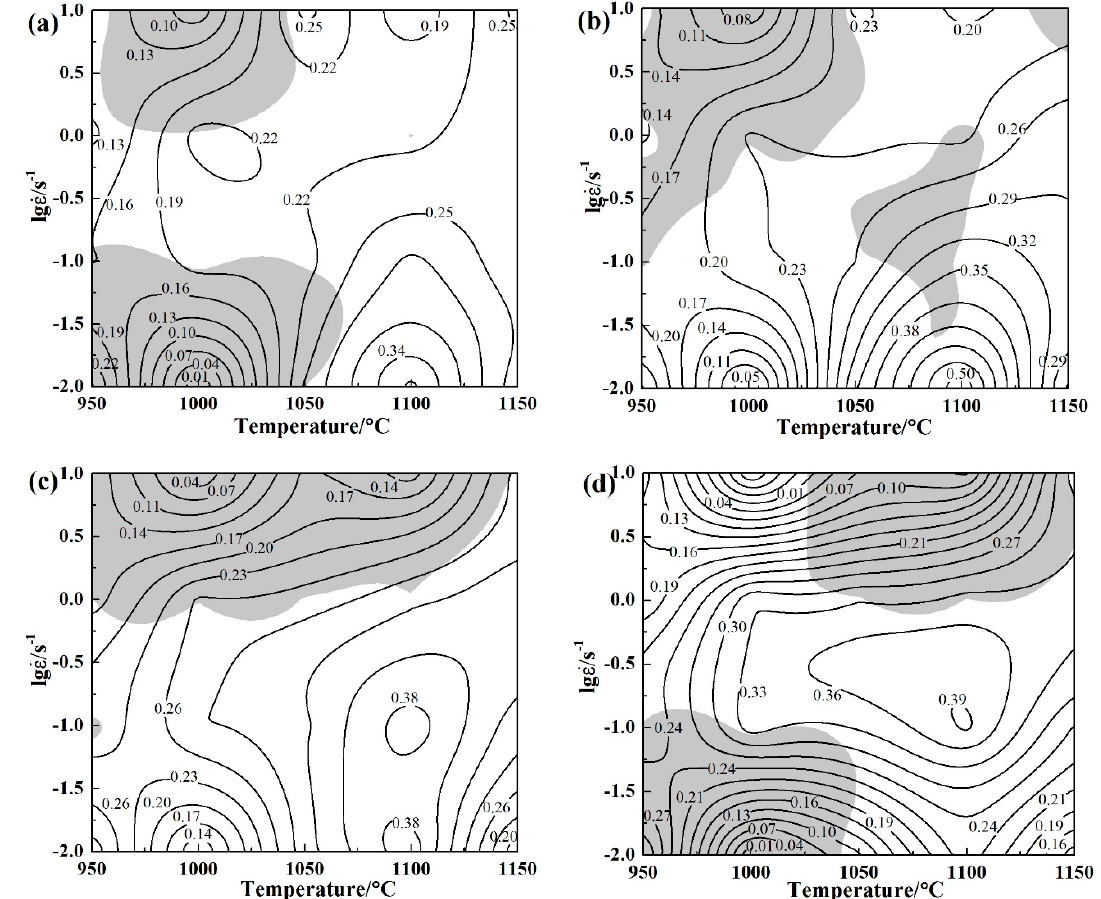
Figure 11. Processing maps of the experimental steel at true strains of: ( a ) 0.2, ( b ) 0.4, ( c ) 0.6 and ( d ) 0.8.